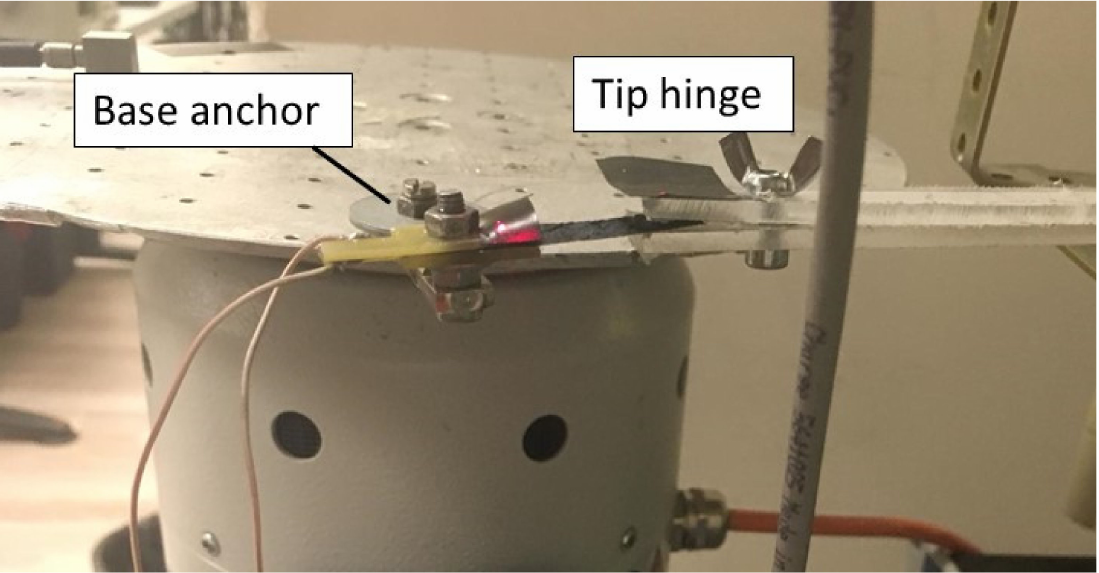
Figure 14. A picture of the setup used to investigate the mechanoelectrical transduction nature. A comparison of the signals obtained when sensing and as actuating working modes (polarities are as indicated in the schematic) is shown in Figure 15a,b,